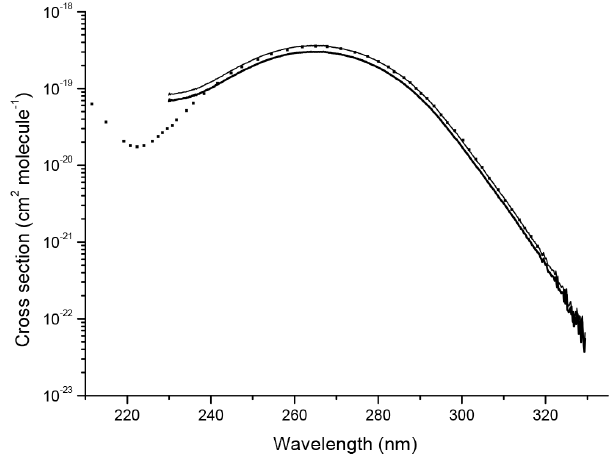
Figure 3. UV spectrum of C 3 O 2 in the spectral range 210 to 330nm. The dots are the spectrum reprinted with permission from Bayes (1961) (copyright 1961 American Chemical Society). The thick black line is our spectrum; the thin black line was obtained by scaling our spectrum by a factor of 1.17 (see